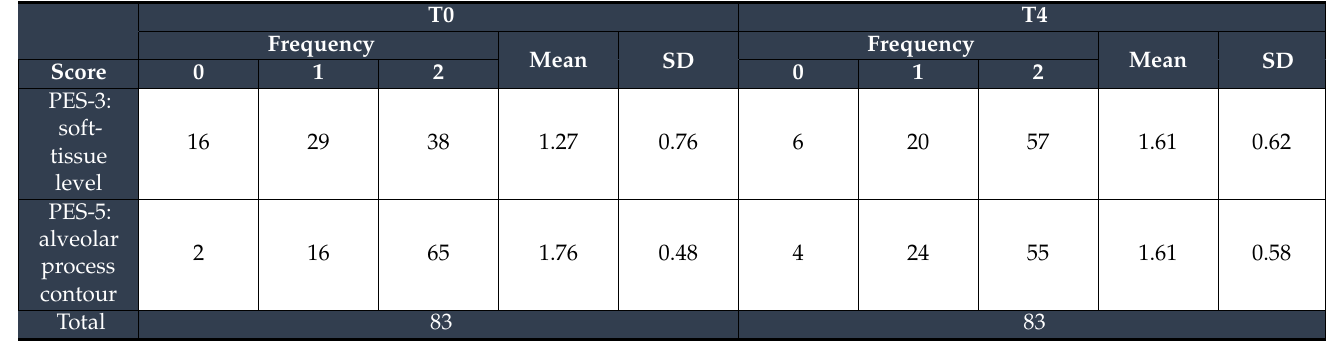
Table 6. Shows the frequency distribution, mean and standard deviation of soft-tissue levels and alveolar process deficiencies of the current research at baseline (T0) and after three years